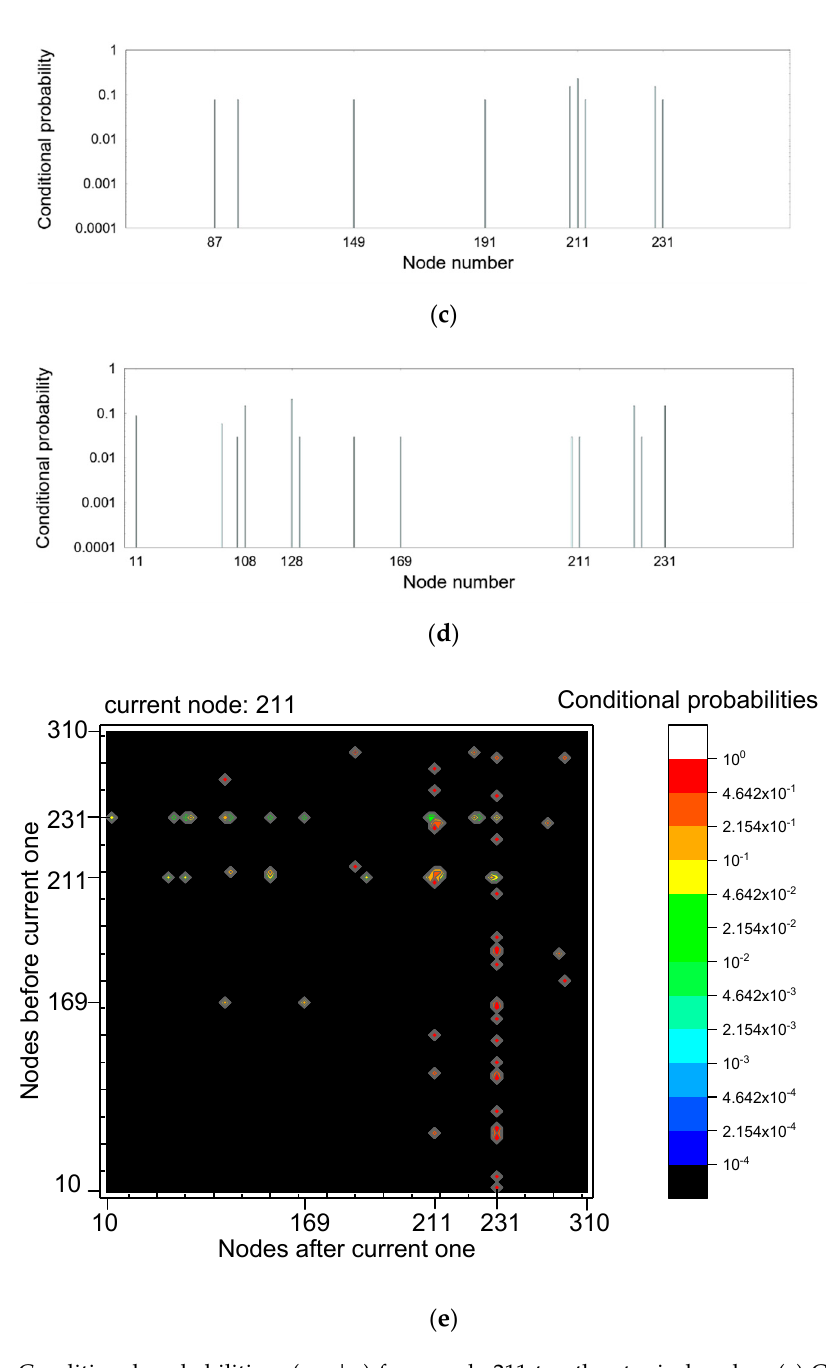
Figure 9. Conditional probabilities p ( n i +1 | n i ) from node 211 to other typical nodes: ( a ) Case with previous visiting node 11. ( b ) Case with previous visiting node 169. ( c ) Case with previous visiting node 211. ( d ) Case with previous visiting node 231. ( e ) Contour plots of matrix entries of conditional probabilities p ( n i +1 | n i ) for n i = 211. x and y axes indicate n i +1 and n i − 1 . Sequence in ( b – d ) along x axis for nodes after current one (211) in ( e ) along x and y axes is listed in Table A1.